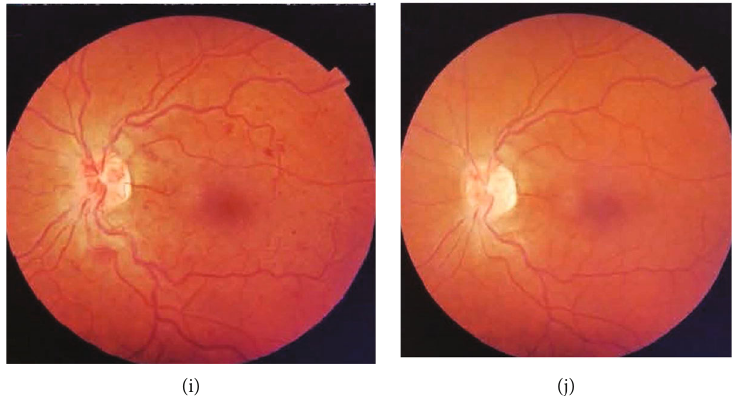
Figure 1: Fundus photo OD with no evidence of pathology (a). Fundus photo OS with mild retinal venous dilatation and tortuosity with scattered blot hemorrhages (b). Fundus auto fl uorescence does not reveal hyper fl uorescent lesions or RPE changes (c, d) apart from the masking e ff ect from blot hemorrhages OS (d). Optical coherence tomography-angiography demonstrates a focal, small area of capillary dropout in the deep capillary plexus (f). Super fi cial capillary plexus, outer retina, and choriocapillaris appear normal (e, g, h). Fundus photo OS, 1 month after presentation with fewer blot hemorrhages (i). Fundus photo after 6 months of OS shows complete resolution of the hemorrhages (j).